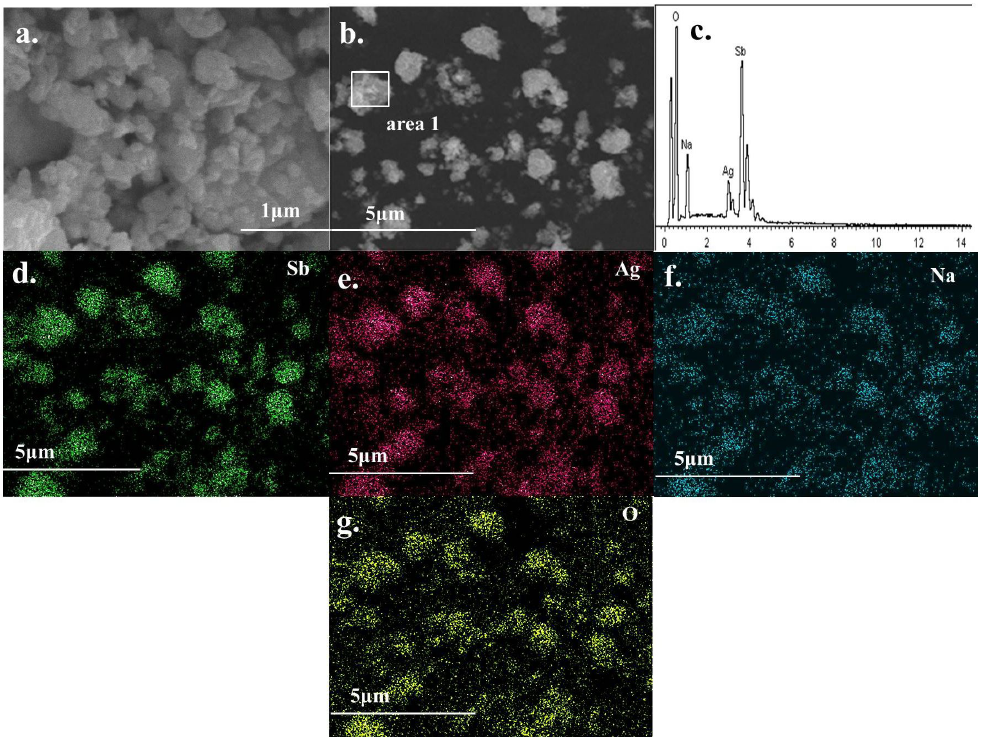
Figure 7. The SEM and EDX results of ANS Catalyst (a. b and c), and the EDX element mapping of Sb (d), Ag (e), Na (f) and O (g).